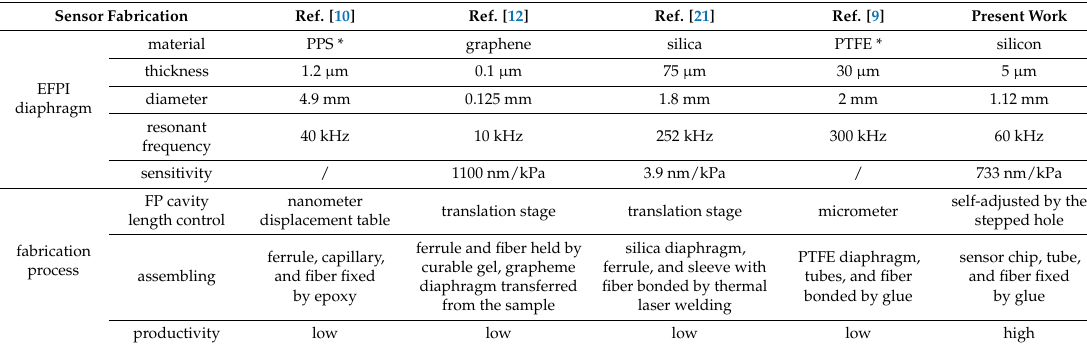
Table 1. Comparison with the four latest EFPI ultrasonic sensors.